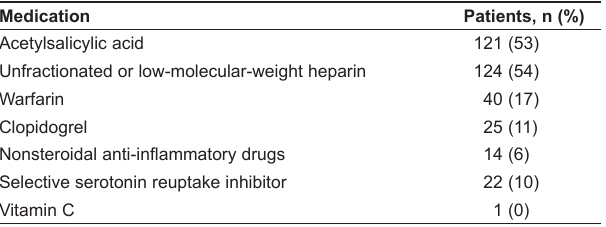
TAble 1 Concomitant medications that can interfere with fecal